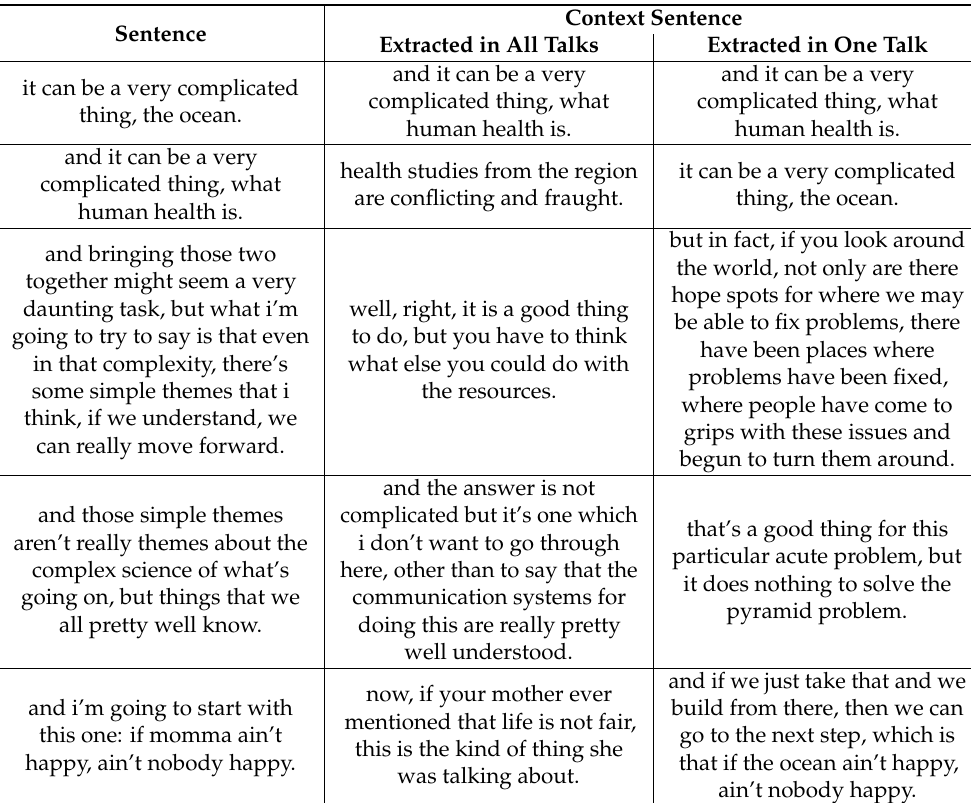
Table 7. Differences in the context sentence extracted within the range of the talk.